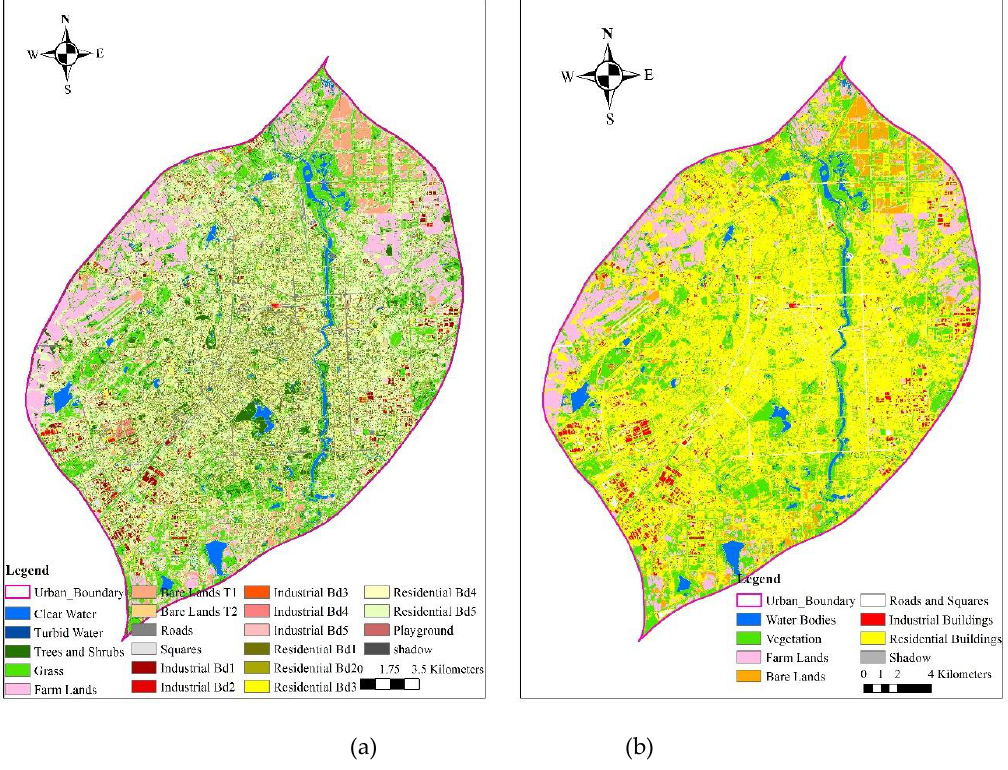
Figure 9. Urban LULC map of Changchun city: ( a ) the third layer, and ( b ) the second layer. Sensors. 2019 , 11 , x FOR PEER REVIEW